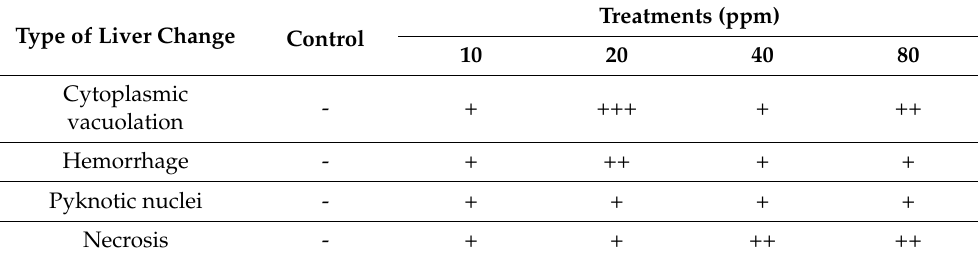
Table 6. Histopathological lesions recorded on the liver Nile tilapia, O. niloticus exposed ZnO- NPs.